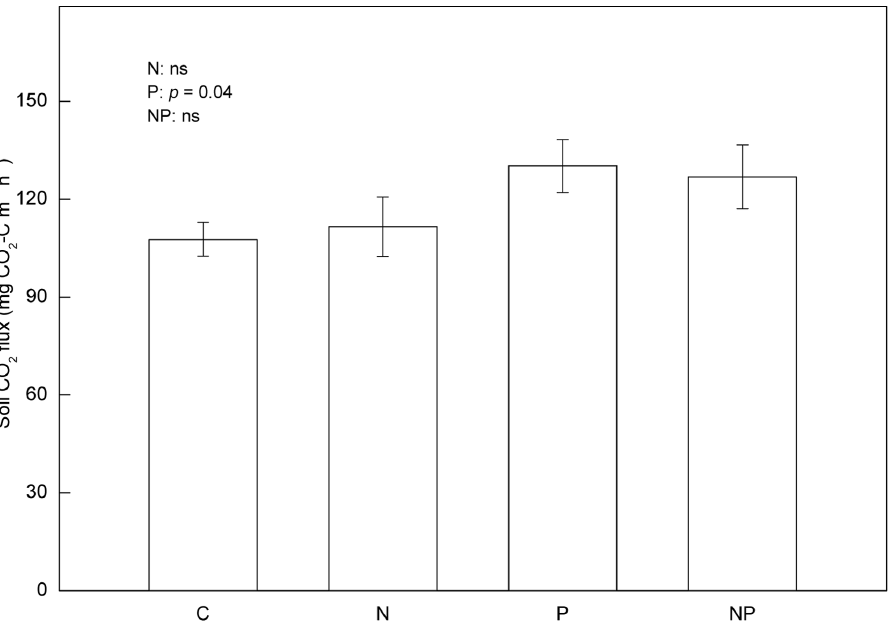
Figure 4. Comparisons of soil respiration between treatments. Values are means for three months. (Data from May-July 2011). C: control, N: nitrogen addition, P: phosphorus addition, NP: nitrogen and phosphorus addition. Error bars show SE (n=5).